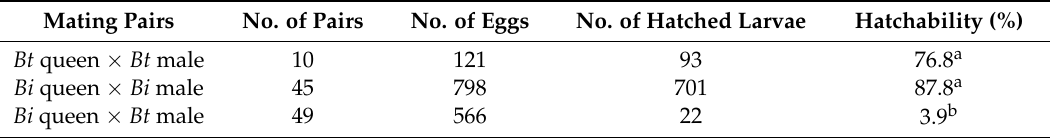
Table 1. Hatchability of eggs derived from intraspecific and interspecific